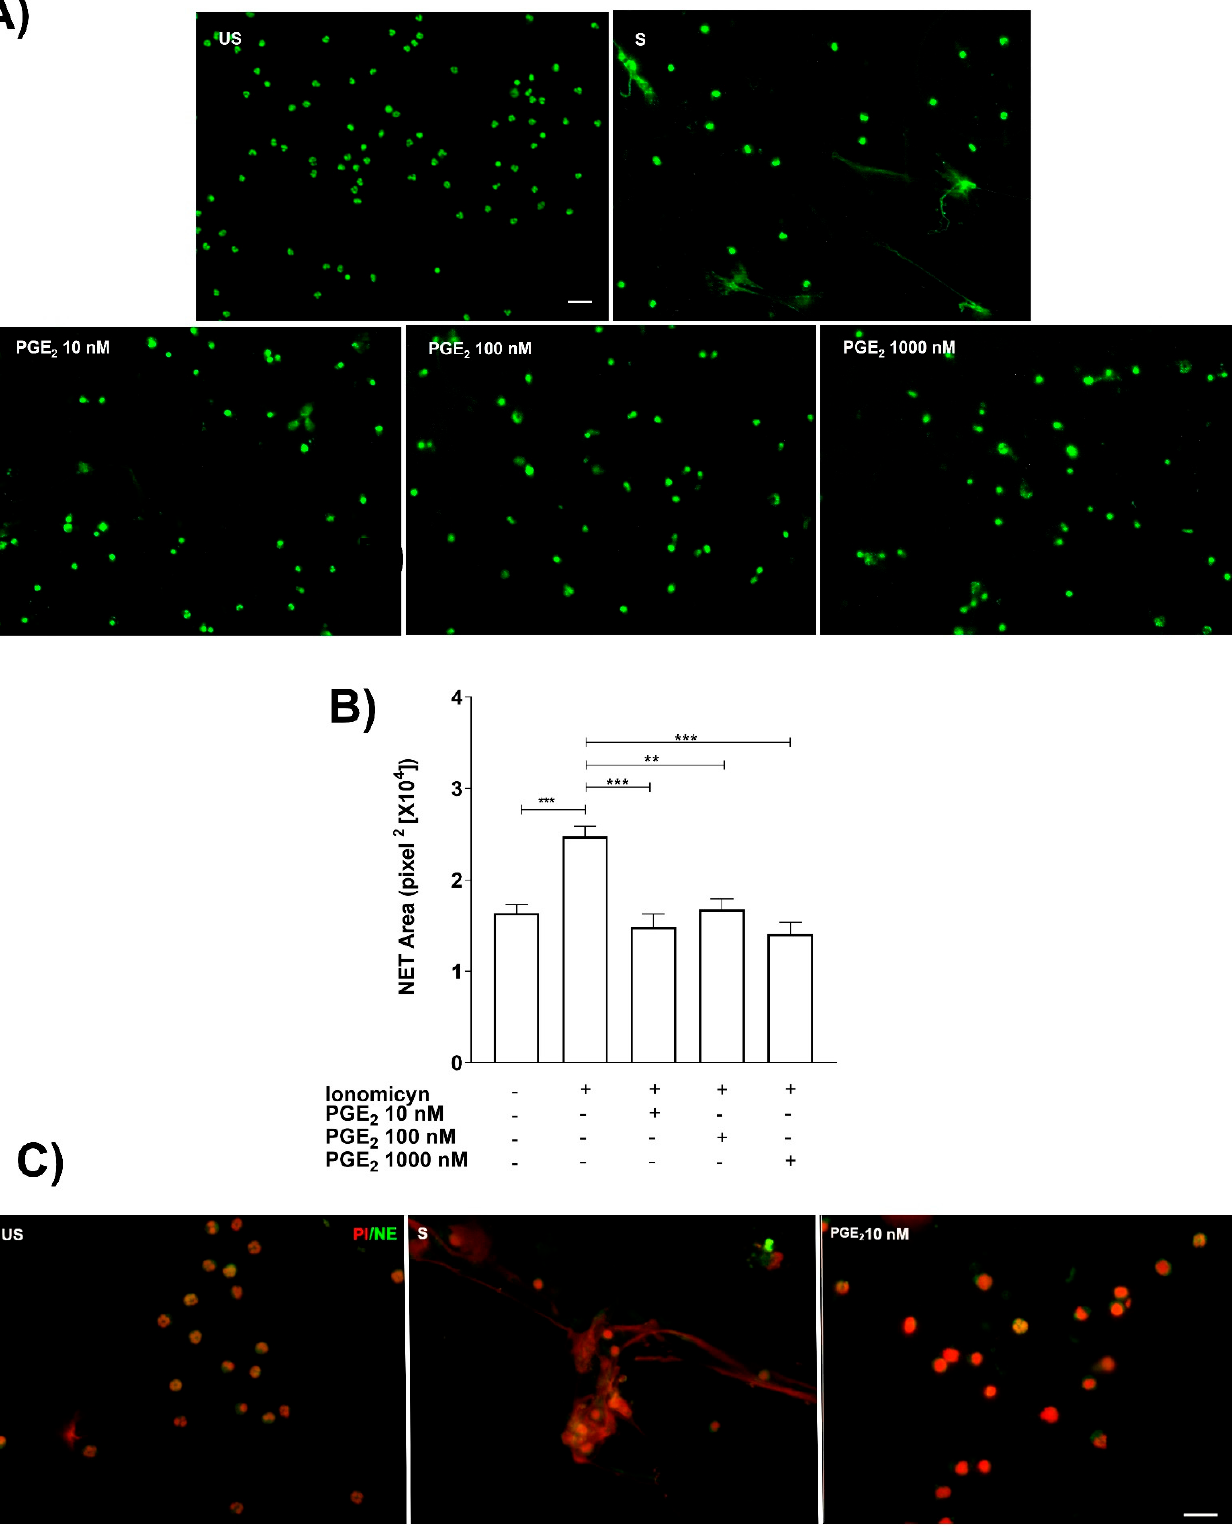
Figure 3. Exogenous PGE 2 inhibits NET release. Representative microscopy images from neutrophils pretreated (15 min before) with different PGE 2 doses (10–1000 nM) and stained with Syto 14-green dye. Scale bar 100 µm ( A ). PGE 2 significantly inhibited NET release from ionomycin (1.25 µM)-treated neutrophils. Bars represent the mean ± SE from five different independent assays. ** p